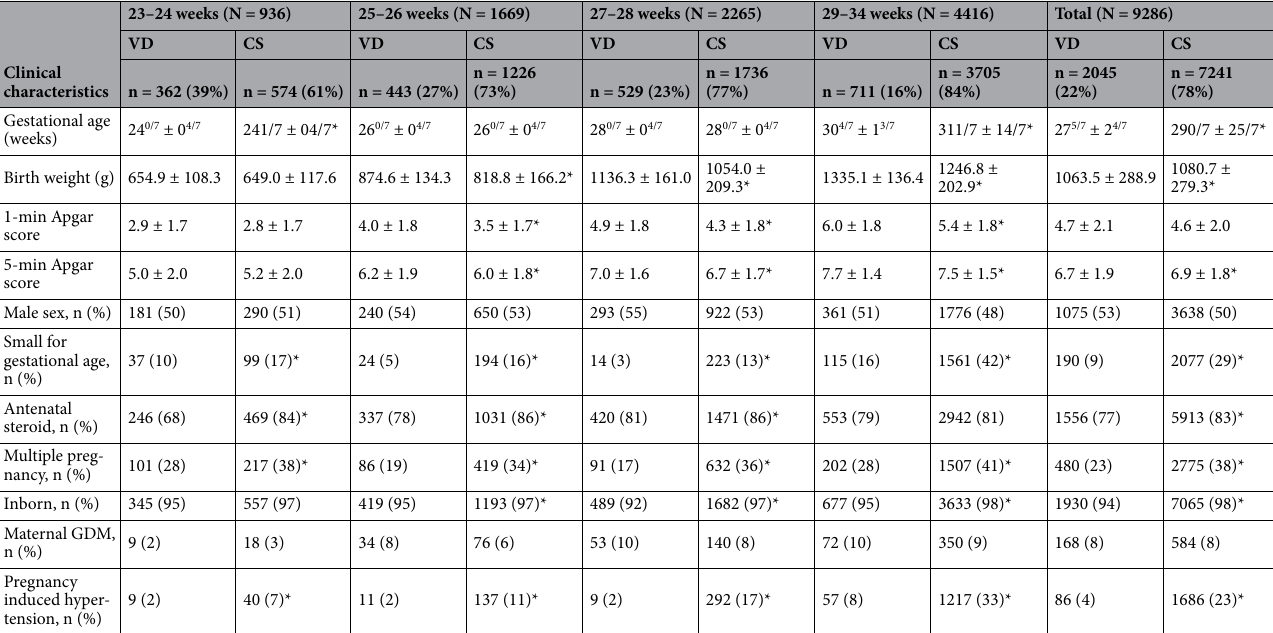
Table 1. Comparison of subjects’ demographic and perinatal characteristics. VD vaginal delivery, CS Cesarean section, GDM gestational diabetes mellitus. *p < 0.05 compared with VD; Values are expressed as mean ± standard deviation or number